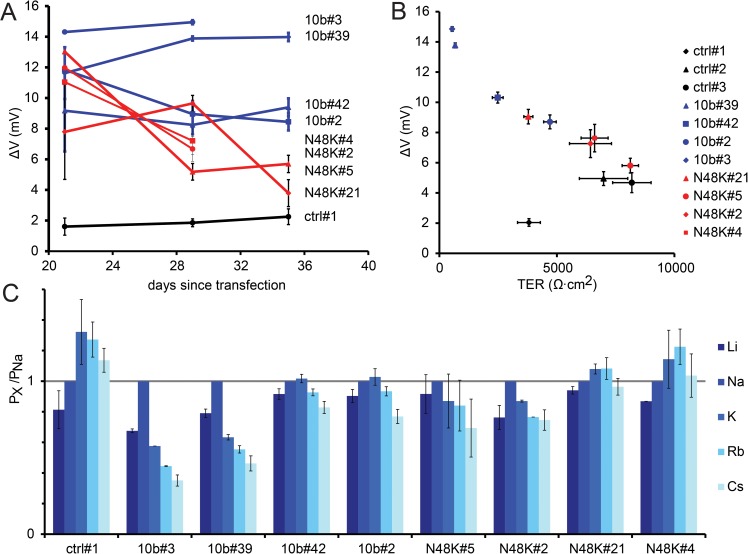
Claudin-10b N48K alters electrophysiological properties in MDCK-C7 cell layers.(A) Dilution potentials (and thus the permeability ratio for Na+ and Cl-; PNa/PCl) of cell layers expressing claudin-10b WT (blue) and claudin-10b N48K (red) are significantly higher than those of control cell layers (black; empty vector). Cell layers transfected with claudin-10b WT maintain these properties over several weeks whereas cell layers transfected with claudin-10b N48K lose these properties over a time-course of three weeks. n = 1–28, means +/- SEM. (B) Expression of claudin-10b WT (blue symbols) cause reduced TER (x-axis) and increased dilution potentials (y-axis) compared to vector transfected controls (black symbols). The effects when expressing claudin-10b N48K (red symbols) were less pronounced. n = 8–40, means +/- SEM. (C) Permeability for monovalent cations (PX) relative to PNa. Expression of claudin-10b WT altered Eisenman-sequence for monovalent cations from Eisenman-sequence IV in control layers to Eisenman-sequence VIII to X, depending on transfection strength. Expression of claudin-10b N48K resulted in Eisenman-sequences between III and X. n = 2–13, means +/- SEM.